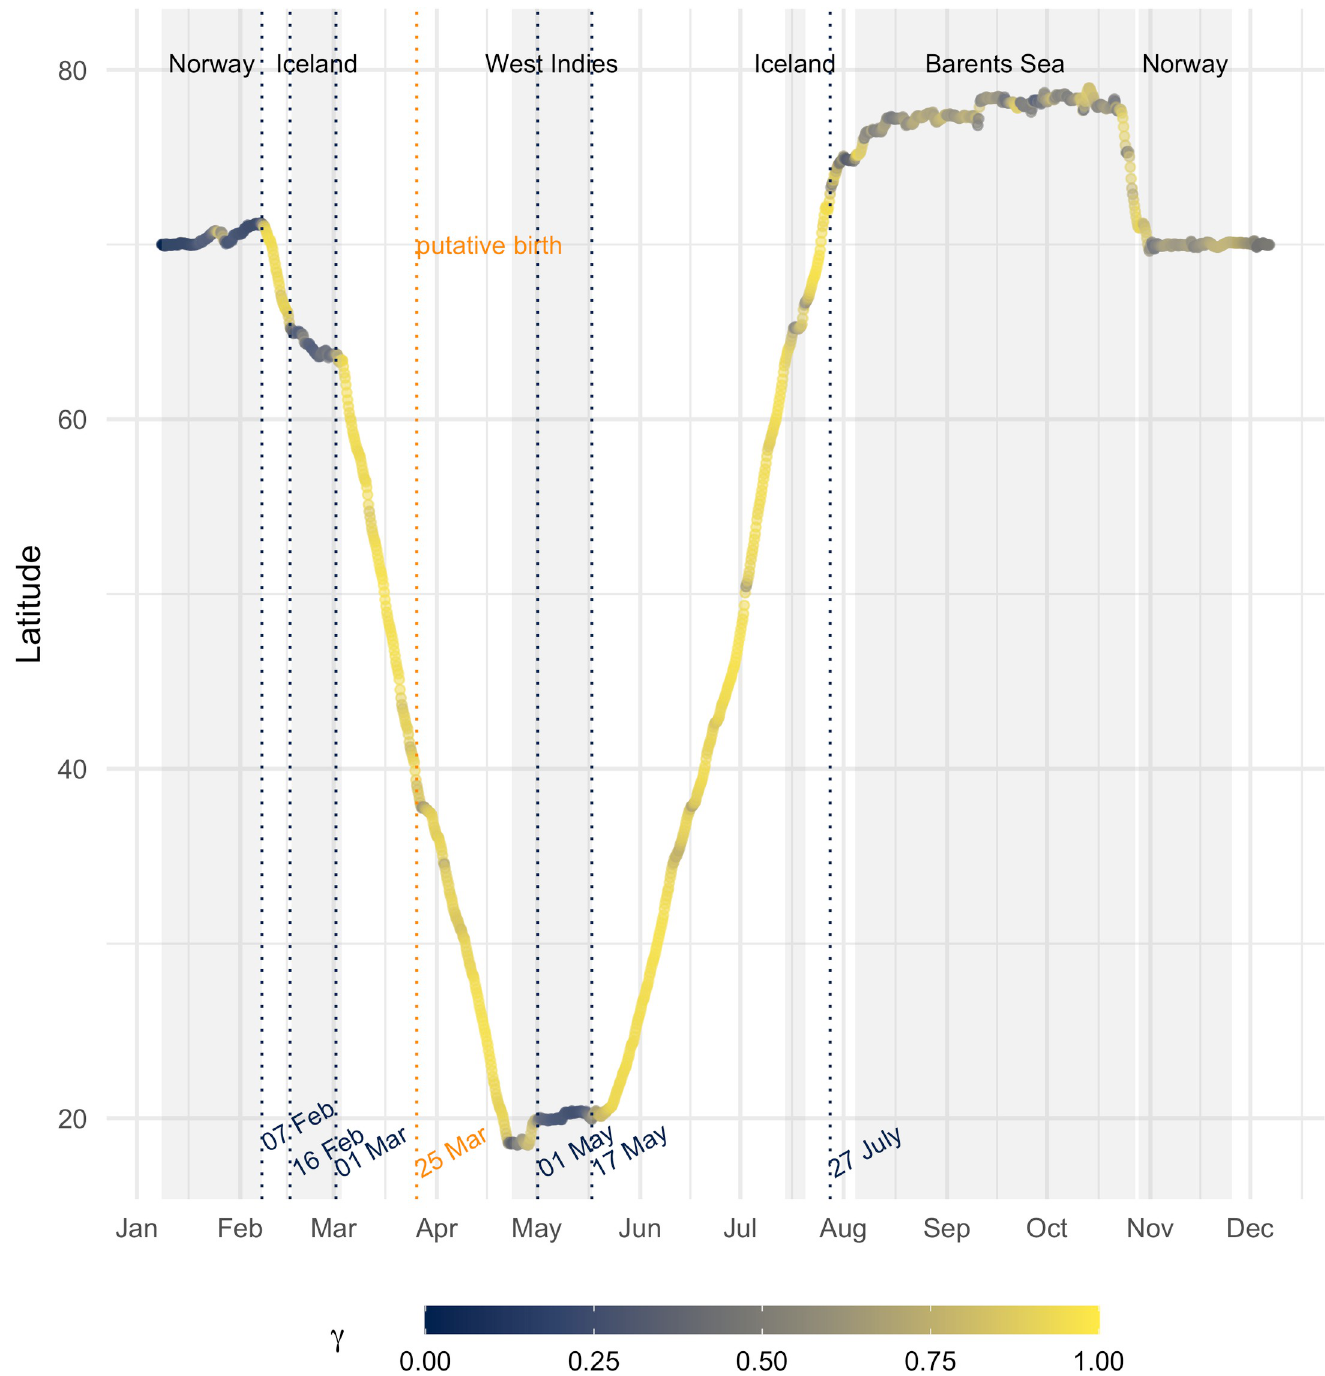
Fig 3. Migration and movement persistence. Migration of the whale as indicated by the change of latitude over time with movement persistence, γ , at the respective location shown in color (0–1). Background shading indicates when the whale was observed over the continental shelf (water depth < 200 m [32]). The time spent on shelf regions are associated with low γ in dark blue indicative of area restricted search behavior, while high γ in yellow indicates transit. The blue dotted lines indicate the break points based on changes in mean movement persistence.